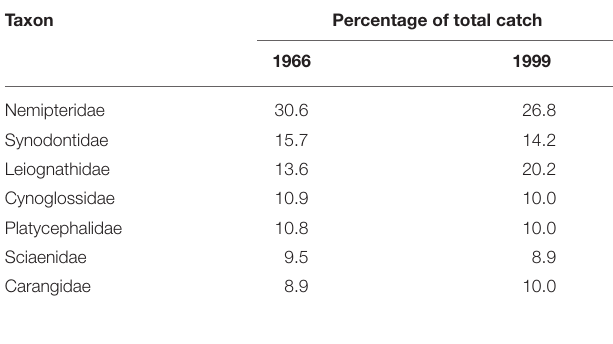
TABLE 1 | Percentage composition of major species of so-called “trash” and low value fish caught in the Gulf of Thailand in 1966 and 1999.